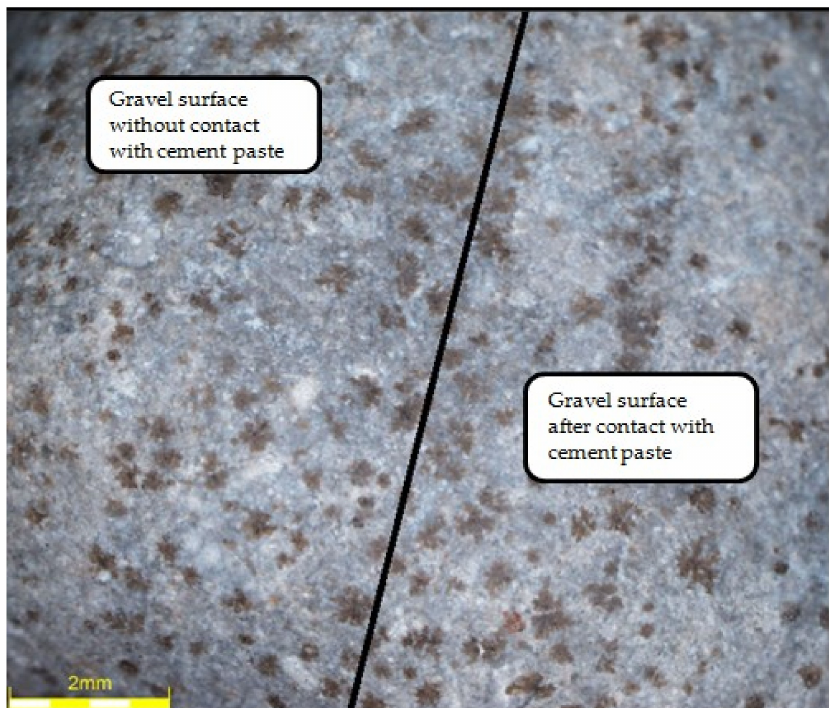
Figure 19. Gravel after thermo-mechanical